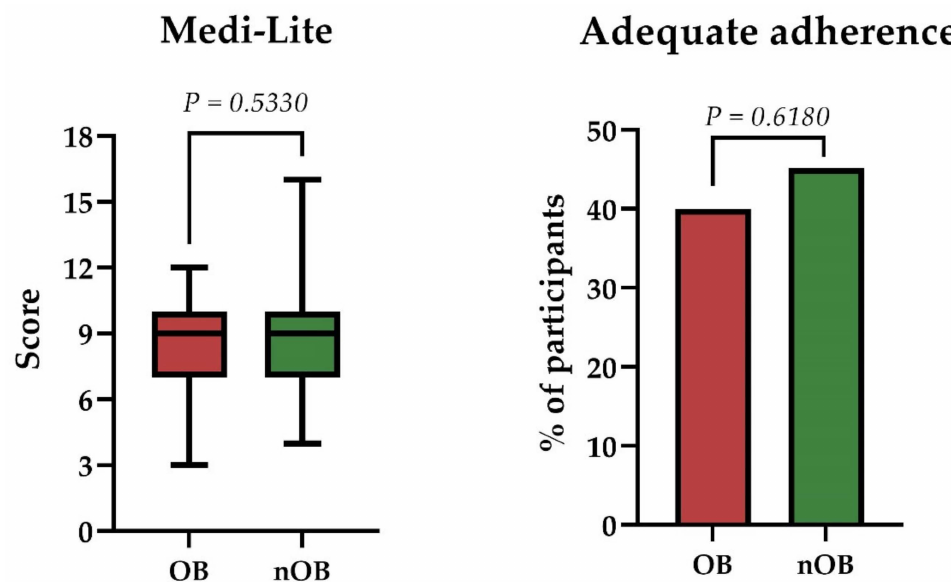
Figure 2. Comparison between patients with (OB) or without (nOB) obesity. Left, Medi-Lite score. Right, proportion of patients with adequate adherence to the Mediterranean diet (defined as a Medi-Lite score >9).